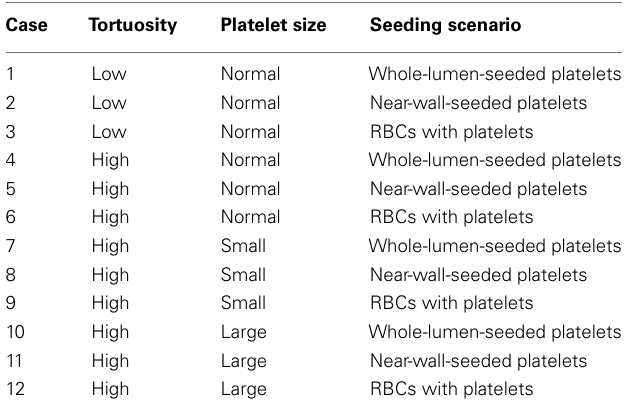
Table 2 | Simulation cases